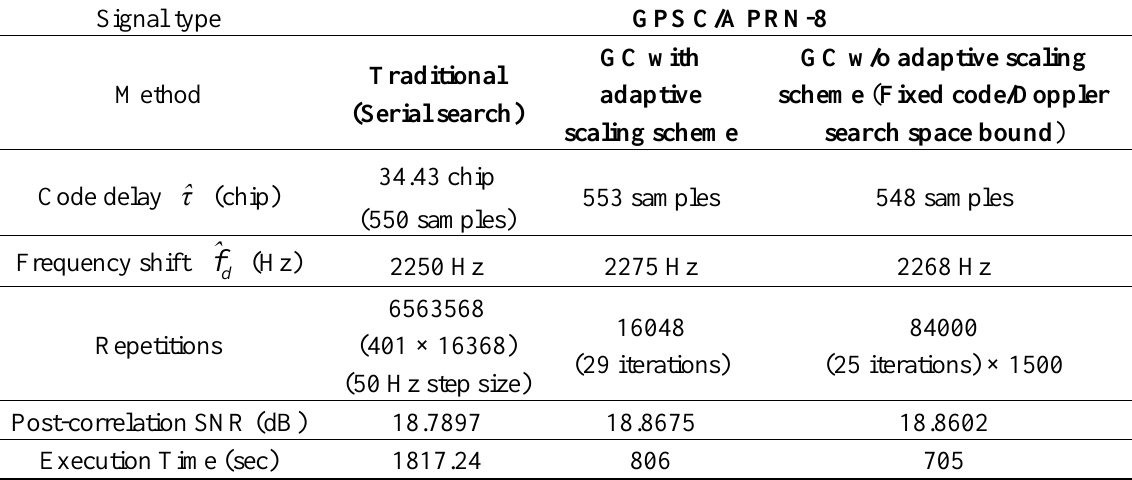
Table 3. Performance comparison of experiment